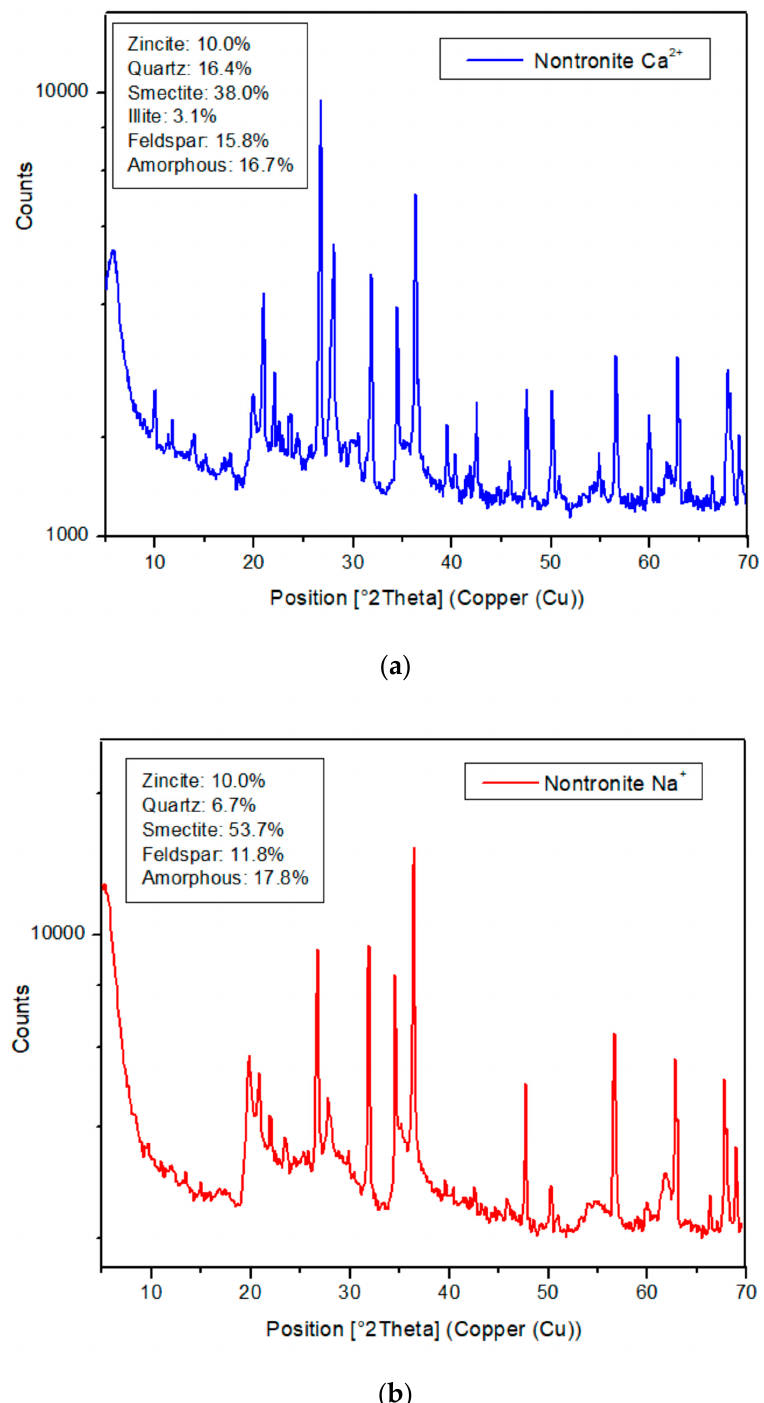
Figure 8. Diffractograms ( a ). Natural clay (Nontronite Ca 2+ ) ( b ). Clay with purification treatment (Nontronite Na + ). Table 3. C ontent of calcium and sodium nontronite obtained by XRD (%wt).